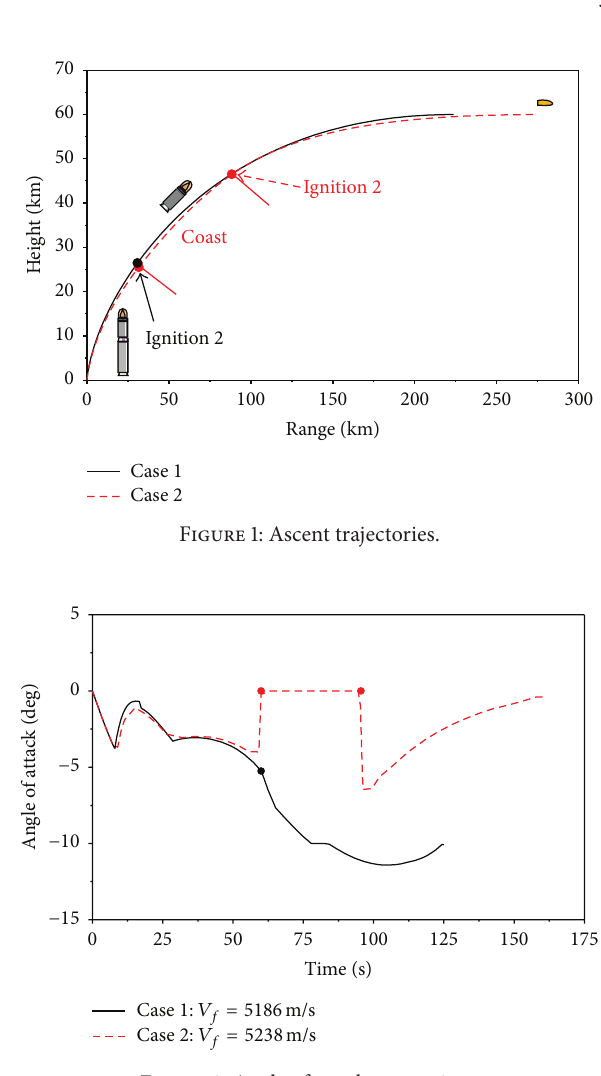
Figure 2: Angle of attack versus